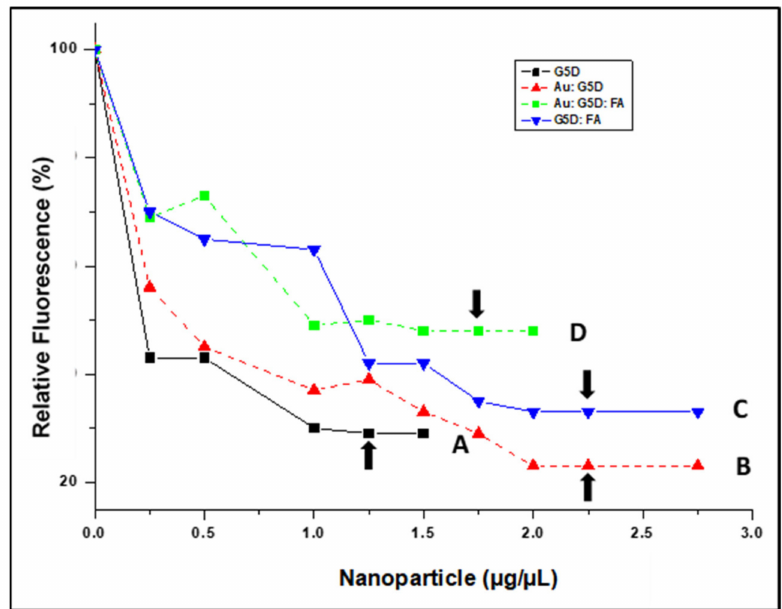
Figure 5. Ethidium bromide displacement assay of ( A ) G5D, ( B ) Au:G5D, ( C ) G5D:FA, and ( D ) Au:G5D:FA NPs. Arrows indicate a point of